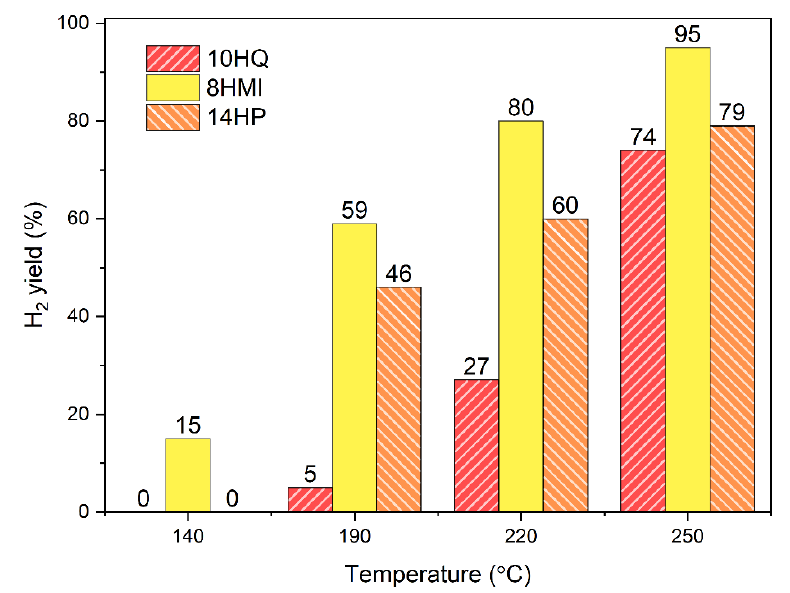
Figure 3. Comparative activity of the studied heterocycles in the dehydrogenation process in presence of 1 wt.% Pd/C.